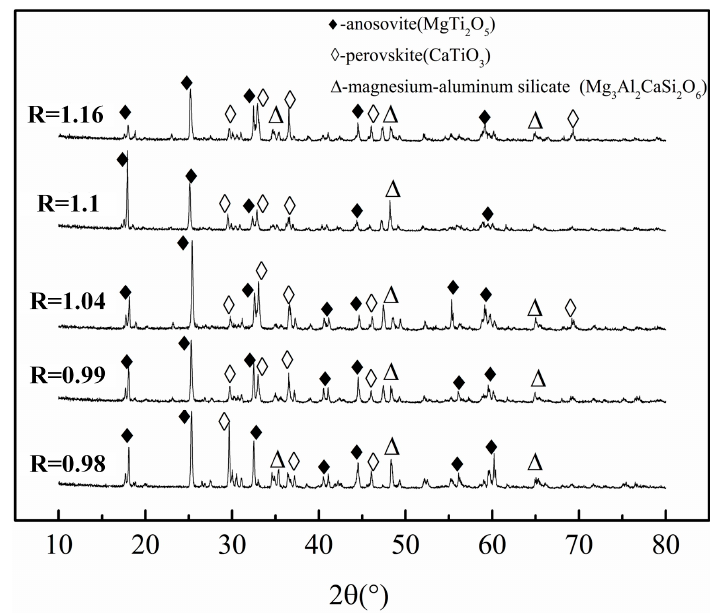
Figure 9. XRD patterns of titanium slag with different quaternary basicity levels by addition of CaO.